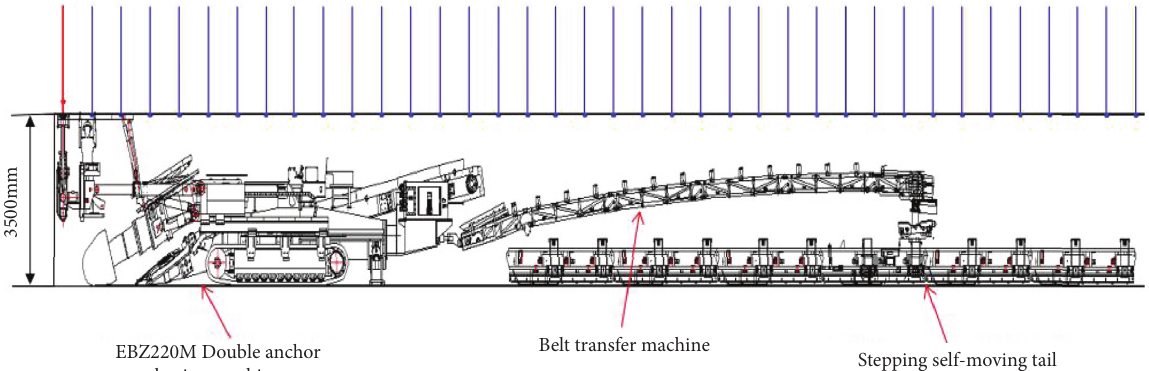
Figure 17: Equipment matching for the rapid excavation system.